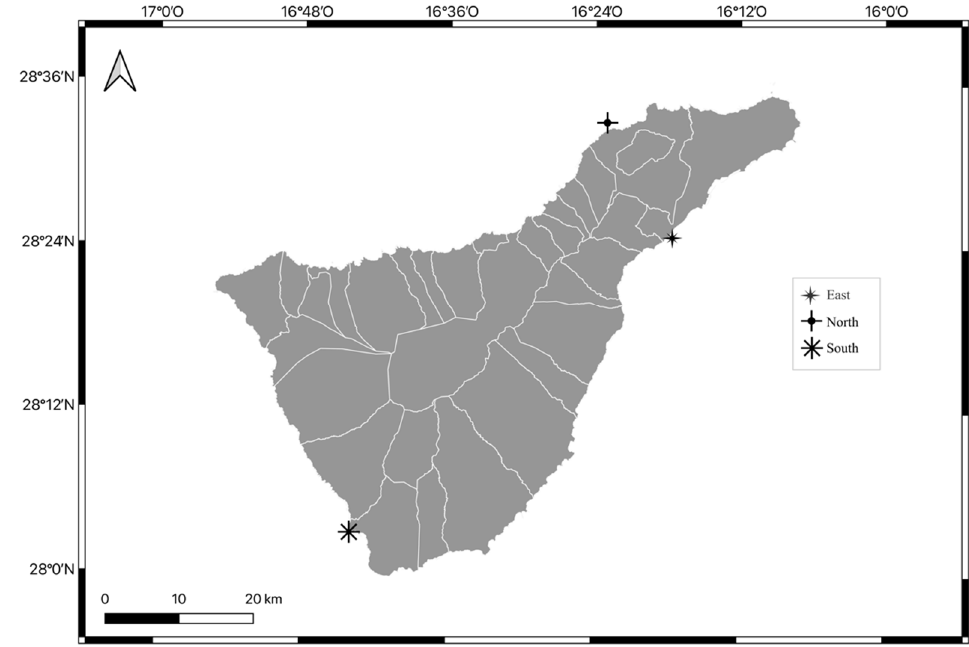
Figure 1. Map of the sampling zones around the island of Tenerife.